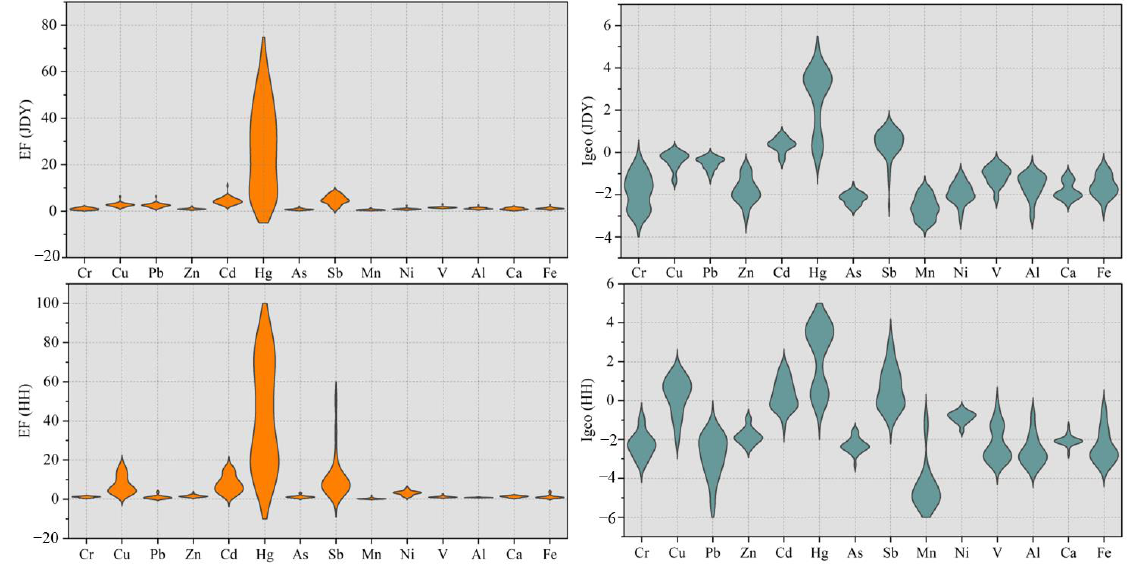
Figure 4. EF and Igeo index variation characteristics profiles in JDY and HH peatlands.